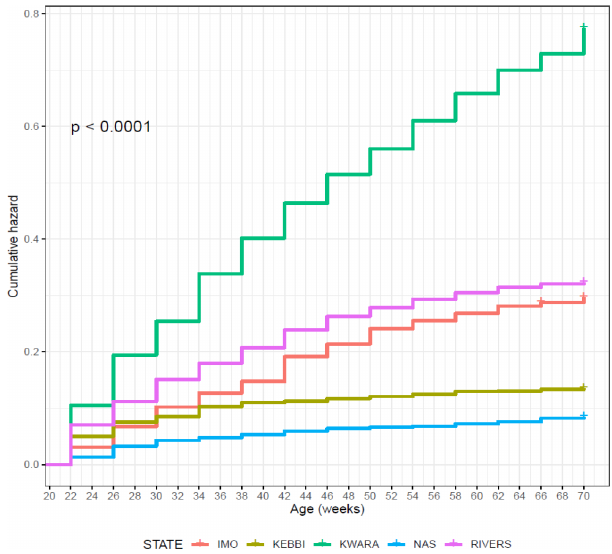
zones compared with higher ambient temperatures in Kwara (23.18 %), Nasarawa (33.50 %) and Kebbi (41.36 %). The